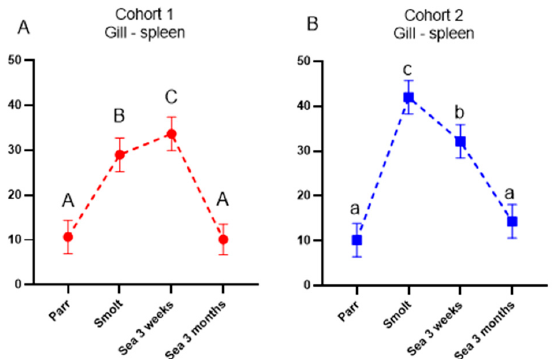
Figure 7. Co-occurrence of largest IgM clonotypes reflecting traffic of B cells from spleen to gill. ( A ), ( B ): the number of fifty largest gill clonotypes also detected in spleen. Data are presented as mean + SEM (n = 6–7). Data points within one cohort not sharing the same letters are significantly different (ANOVA, LSD test, p < 0.05).